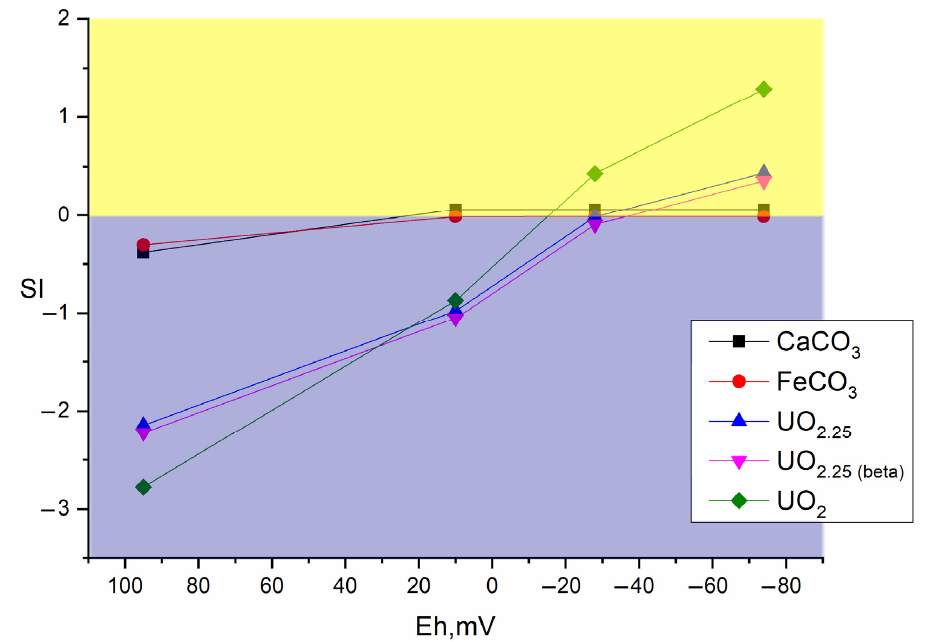
Figure 7. Distribution of main mineral phases before and after microbial processes in the sample without additives.